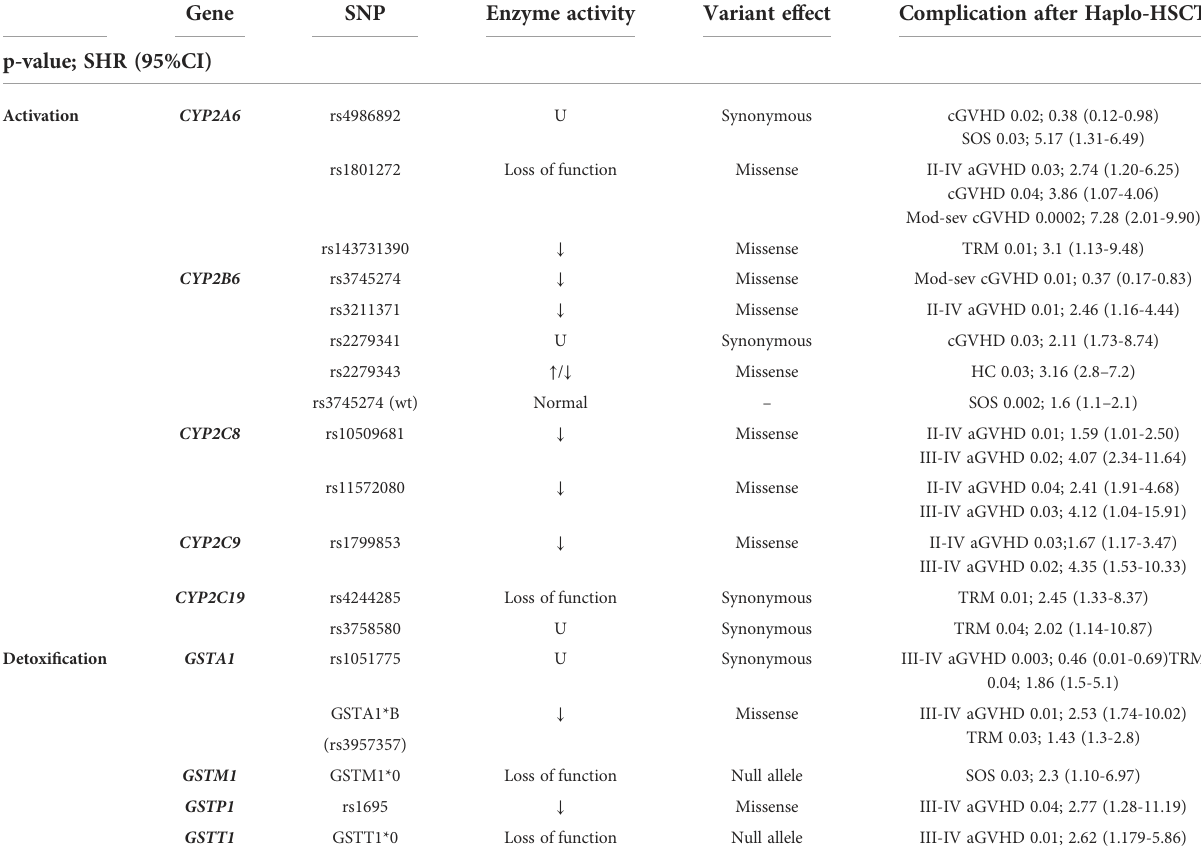
TABLE 3 Univariable analysis of the association of genetic variants in cyclophosphamide metabolism genes with complications after Haplo-HSCT.